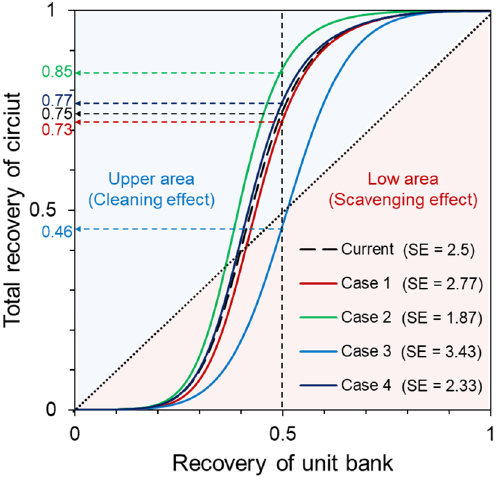
Figure 6. Circuit partition functions of current process (black line) and alternative process (cases 1–4). Dotted line represents diagonal line. SE is separation efficiency (d(C/F)/dP, P = 0.5).